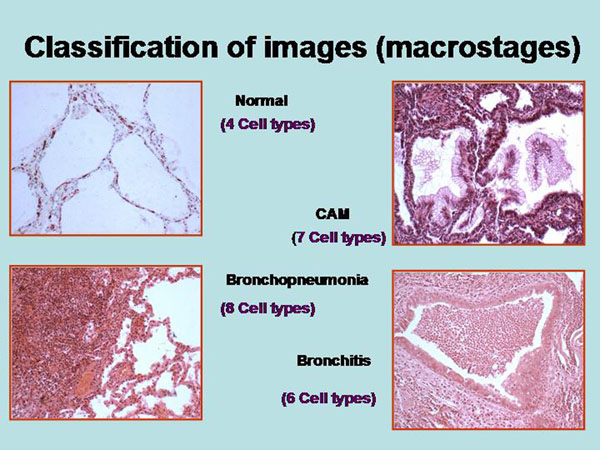
Example of cell types in histological images of lung diseases (normal, congenital adenomatoid malformation (CAM), bronchopneumonia, and bronchitis) used for entropy calculation (Shannon and Tsallis)